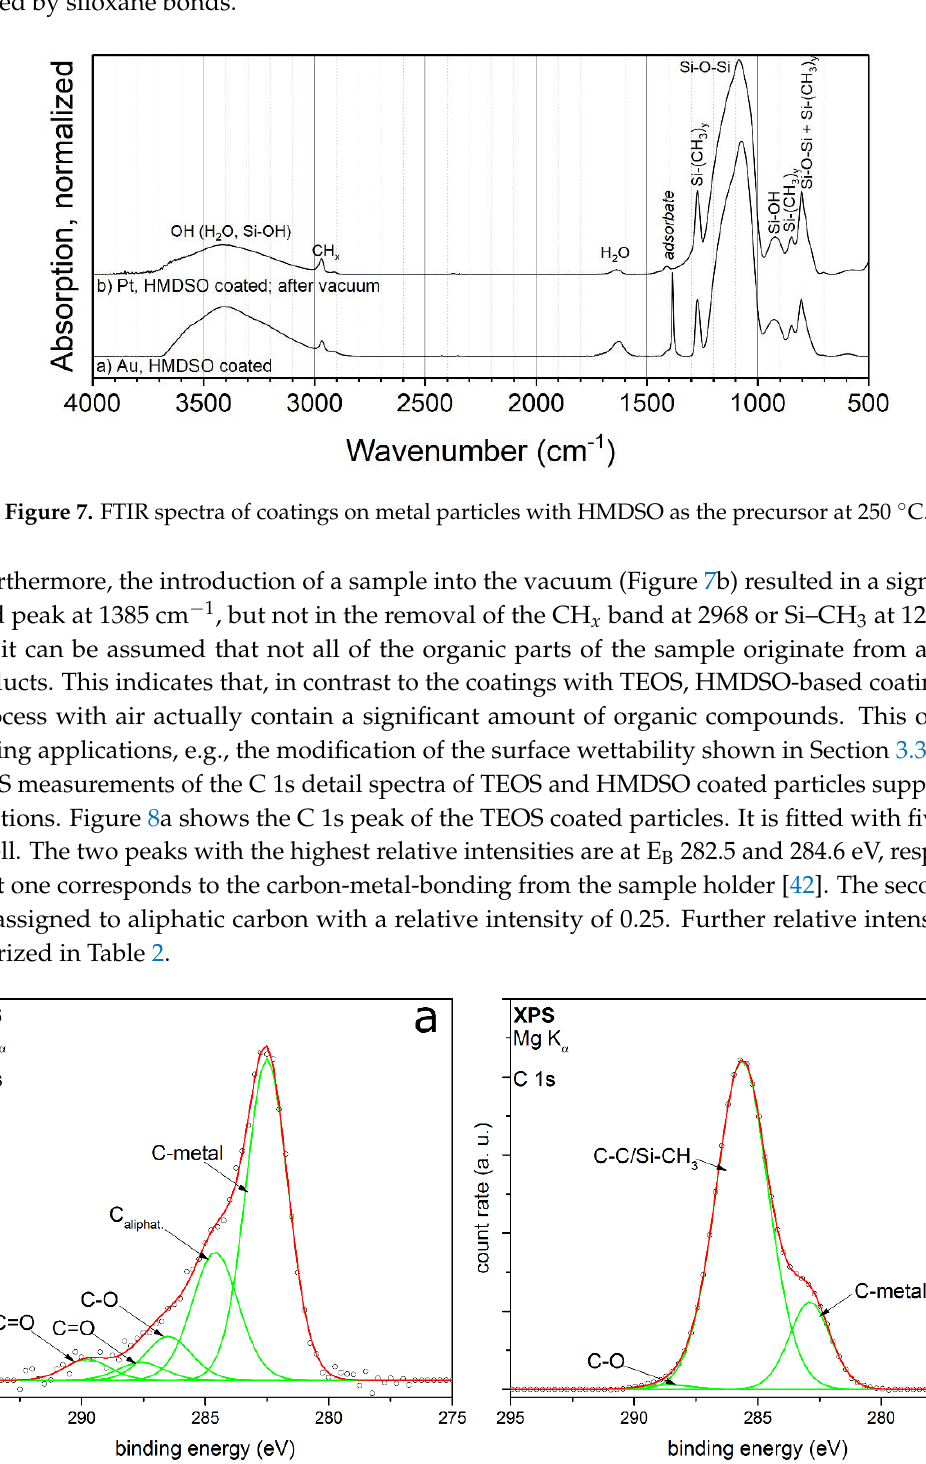
Figure 8. XPS detail spectra C 1s of coated titania particles with TEOS ( a ) and Pt particles with HMDSO as the precursor ( b ).